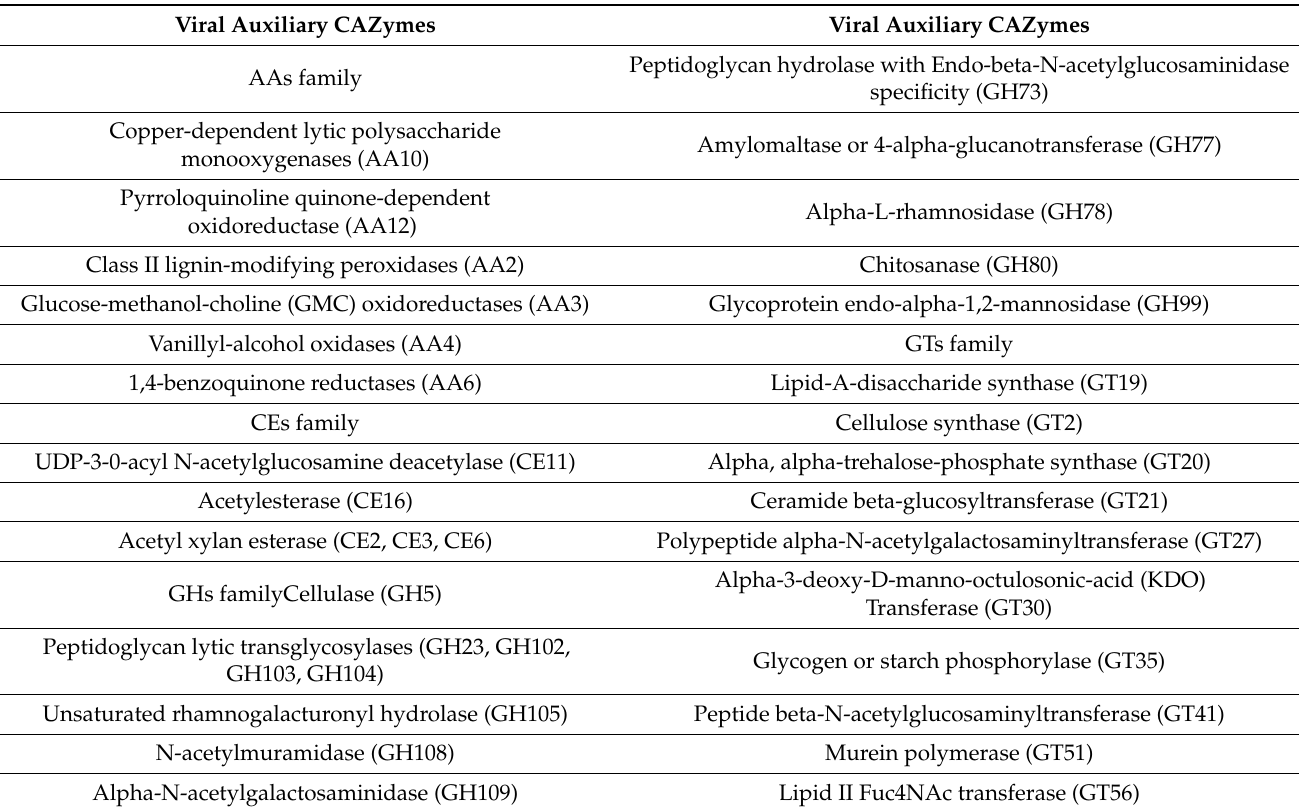
Table 2. Annotated auxiliary CAZymes from vinegar Pei